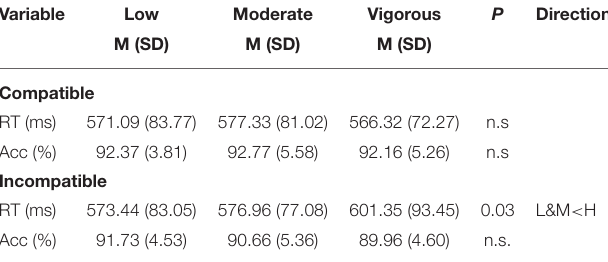
TABLE 3 | Task performance by exercise intensity during compatible and incompatible